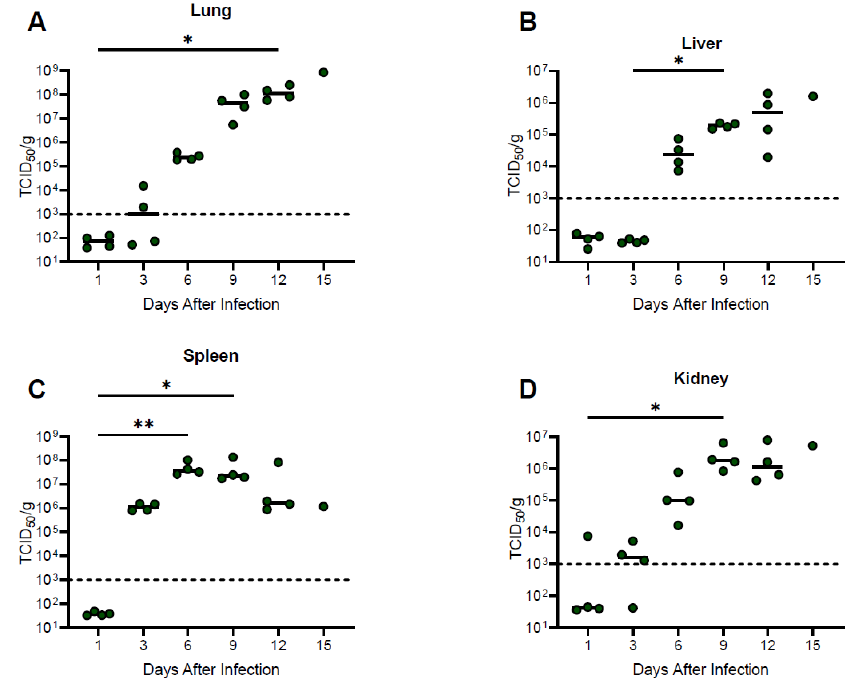
Figure 3. Temporal analysis of infectious viral loads from guinea pigs infected with NML-61/GPA. Twenty-four guinea pigs were inoculated with 100LD 50 of NML-61/GPA. Groups of four animals were euthanized at indicated days post-inoculation and Lung ( A ) Liver ( B ) Kidney ( C ) and Spleen ( D ) samples collected and analyzed by standard cell culture techniques for the presence of infectious Lassa virus. Dots represent individual animal values, bar represents group averages. Dashed line represents the lower limit of confidence in the infectious assay. Significant differences where p < 0.05 and <0.01 are indicated by * and **, respectively.